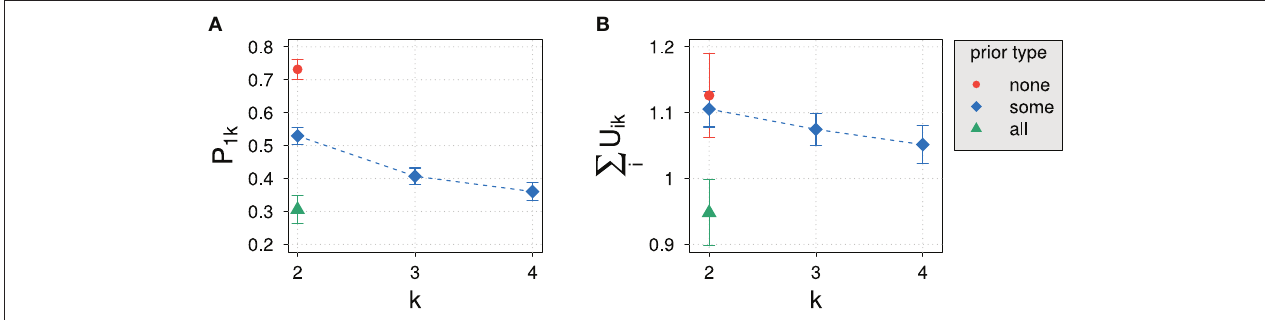
FIGURE 9 | Experimental results for the prior probability for normalized slider values P 1 k (A) and for average sums of unnormalized slider values (B) for different domain sizes k and prior types in Experiment